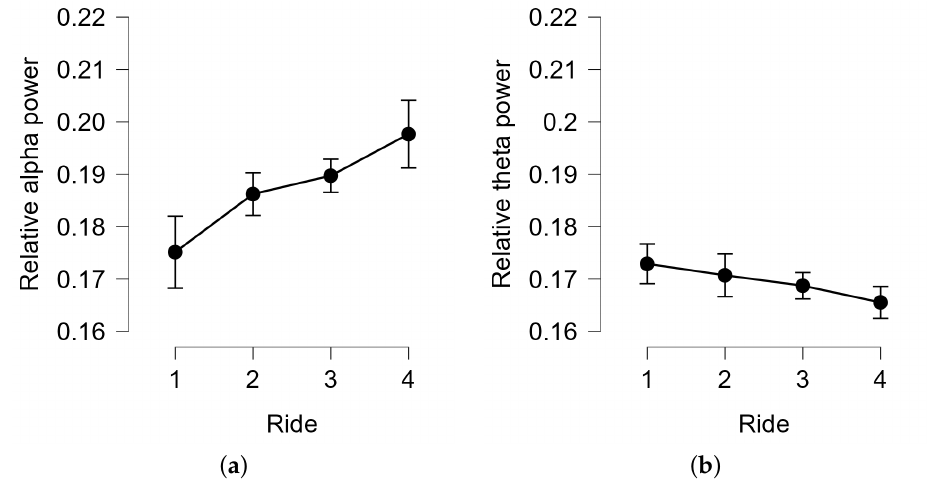
Figure 4. Relative power in the alpha and theta bandwidth over the four sequential rides. The error bars represent a 95 % confidence